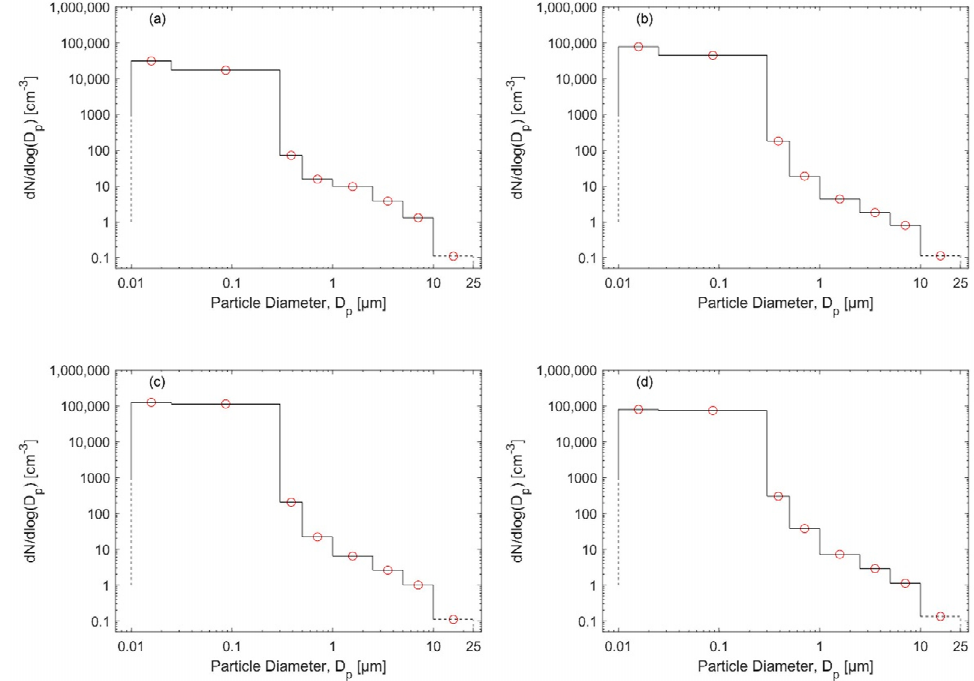
Figure 2. Particle number size distributions derived from the measured size fractions (Table S1): ( a ) rural background—outside the populated areas in the city, ( b ) urban background—University of Jordan campus and nearby areas, ( c ) main roads—traffic, and ( d ) city center—urban.